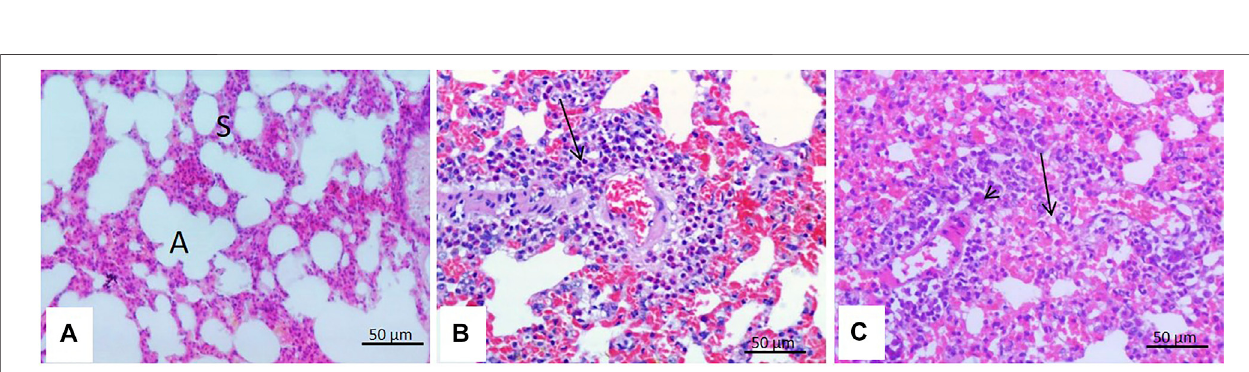
FIGURE 5 | Effect of malathion on the brain. (A) Brain of control rats showing intact neuronal cells (N) and blood vessels (V) in the neuropil (P) of the cerebrum. (B) Brain of rats treated with malathion for 24 h showing a slight perivascular cuff (arrows). (C) Brain of rats treated with malathion for 21 days showing cerebral malacia (arrow) with the in fi ltration of large number of glial cells (arrow head).